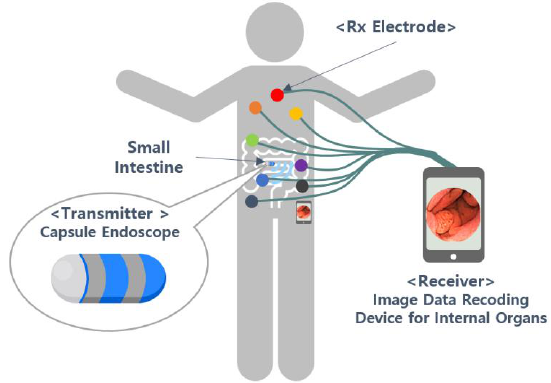
Figure 1. Example of the use of the wireless capsule endoscopy (WCE) system to explore the state of the small intestine.